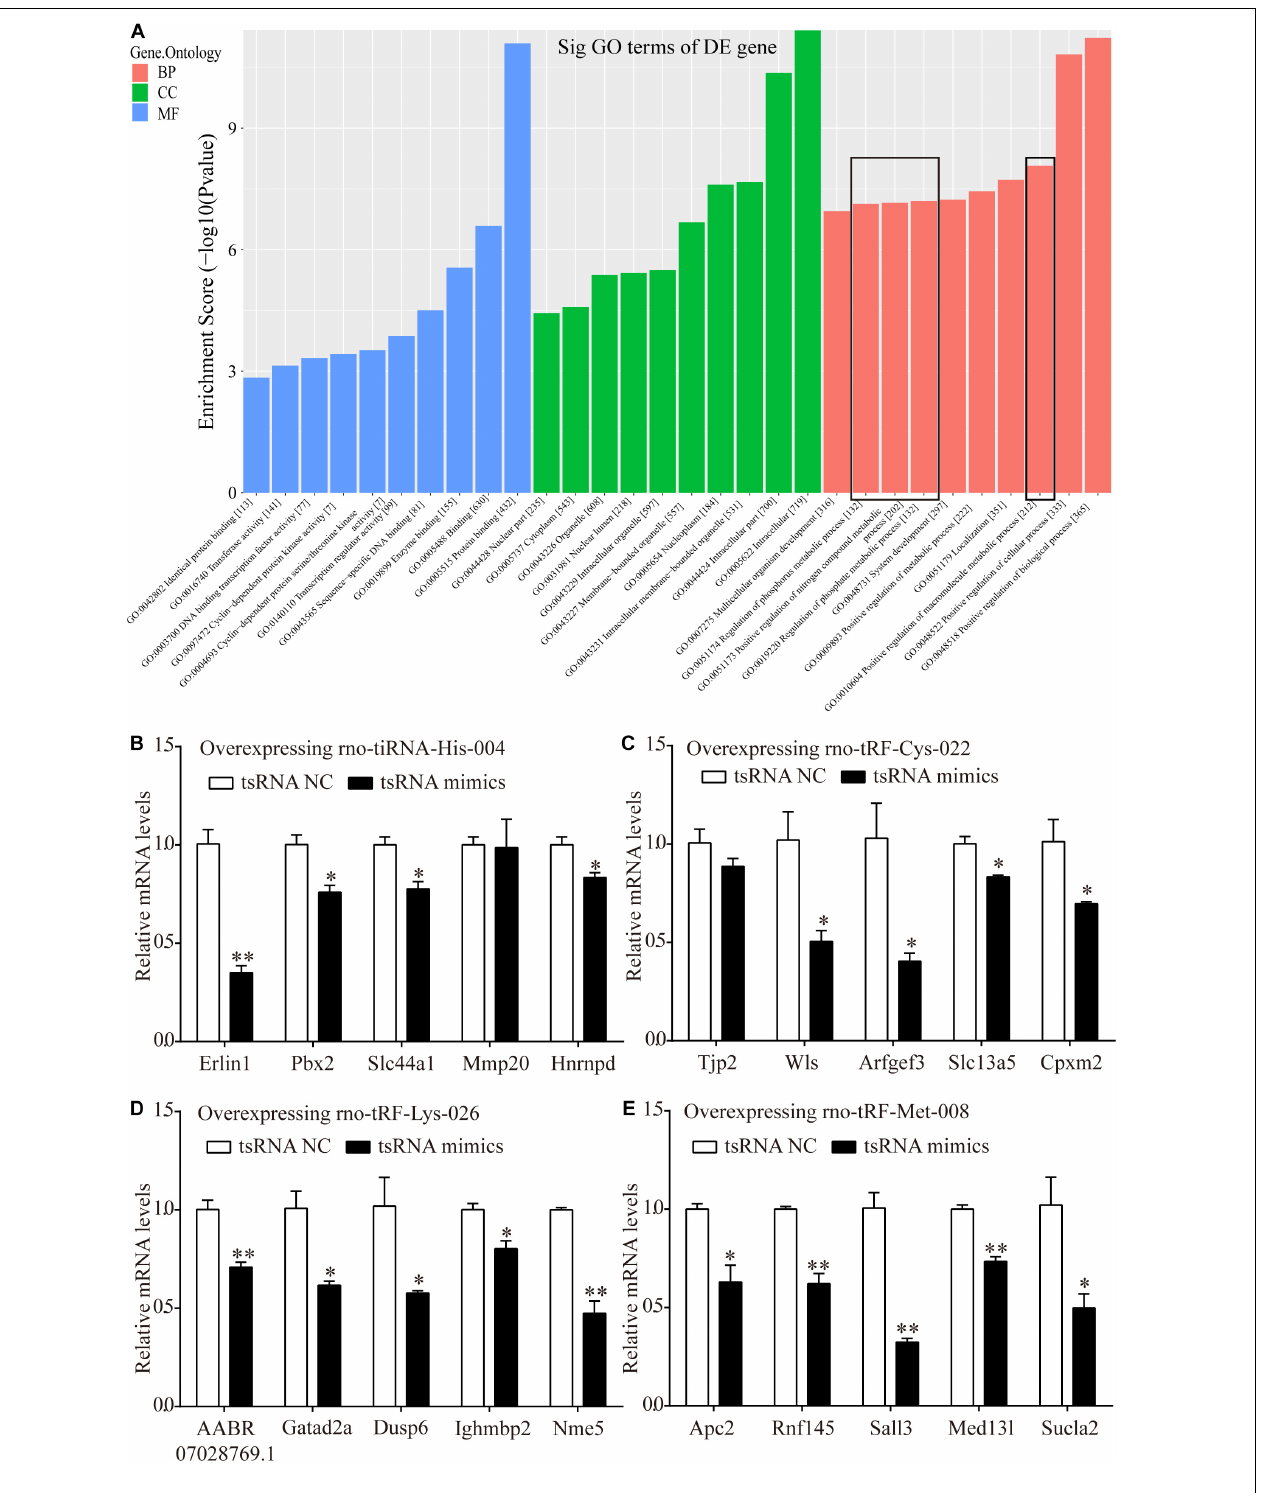
FIGURE 7 | Target mRNAs regulated by four candidate tsRNAs enriched in macromolecular metabolic process and their verification via qRT-PCR. (A) The general GO annotations for biological processes, cellular components, and molecular functions of the target mRNAs regulated by the four candidate tsRNAs. (B) The relative mRNA levels enriched in macromolecular metabolic process in H9c2 cells transfected with rno-tiRNA-His-004 mimics. (C) The relative mRNA levels enriched in macromolecular metabolic process in H9c2 cells transfected with rno-tRF-Cys-022 mimics. (D) The relative mRNA levels enriched in macromolecular metabolic process in H9c2 cells transfected with rno-tRF-Lys-026 mimics. (E) The relative mRNA levels enriched in macromolecular metabolic process in H9c2 cells transfected with rno-tRF-Met-008 mimics. The data are presented as the mean ± SEM ( n = 3). * P < 0.05, ** P < 0.01 compared with NC group.